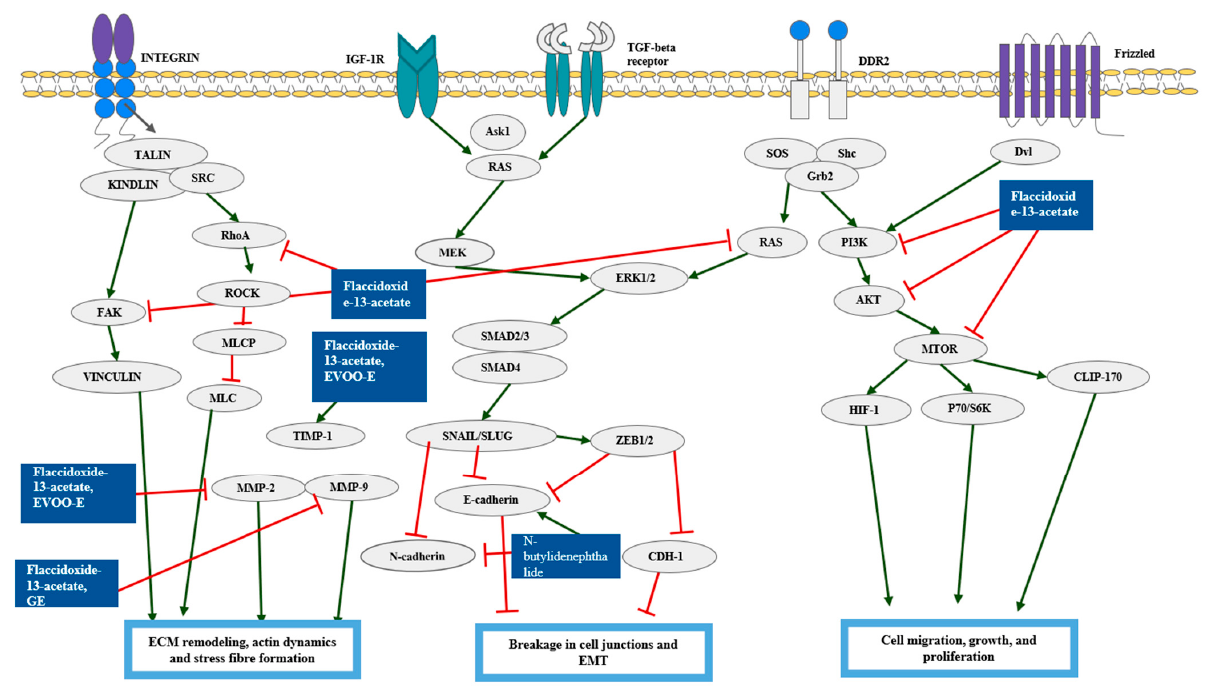
Figure 4. Schematic diagram of metastasis. ECM is a highly organized structure where cells can follow the matrix fibers and migrate. By remodeling it, cells can move to nearby tissues. ECM remodeling is regulated by factors such as MMP-2 and MMP-9. Actin dynamics is essential for the Epithelial-to-Mesenchymal Transition (EMT), which gives cells the migratory potential. ZEB1/2 is a key molecule regulating EMT. HIF-1 regulates the genes and cause metastasis. Natural products were capable of suppressing the molecules related to the metastasis. Abbreviation: Ask1, Apoptosis signal-regulating kinase 1; AKT, Protein kinase B; CDH-1, Cadherin-1; CLIP-170, Cytoplasmic Linker Protein; Dvl, disheveled; DDR2, Discoidin Domain Receptor 2; ERK1/2, Extracellular signal-regulated kinase 1, 2; E-cadherin, epithelial cadherin; N-cadherin, neural cadherin; EVOO-E, Extra